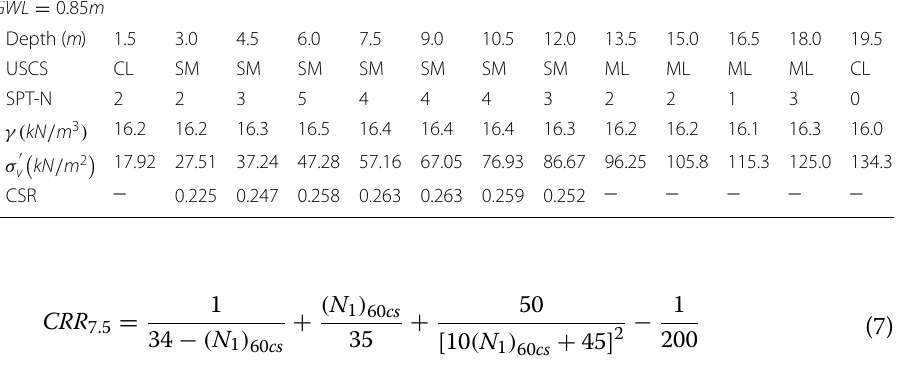
Table 2 Soil characteristics of borehole B-25 0.85 m GWL =